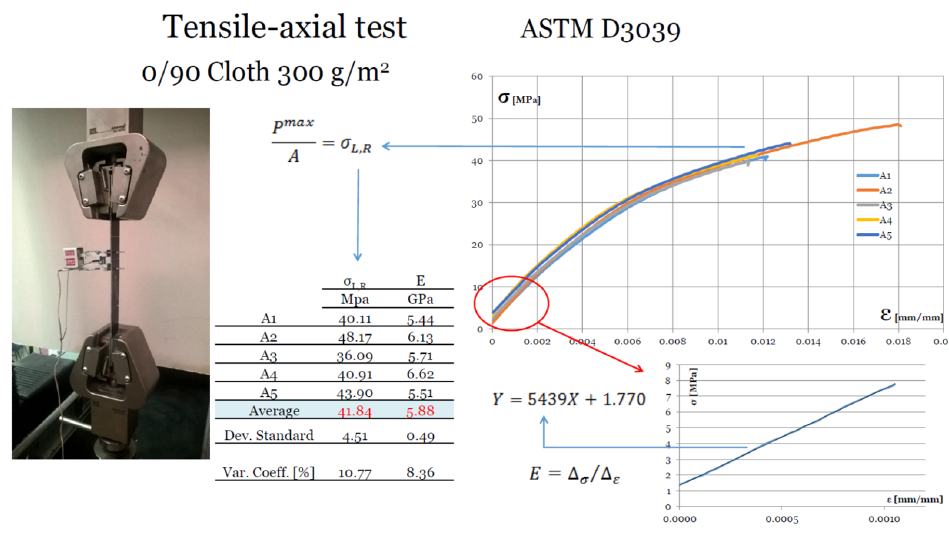
Figure 13. Tensile-axial test according to ASTM D3039 of biaxial linen-reinforced